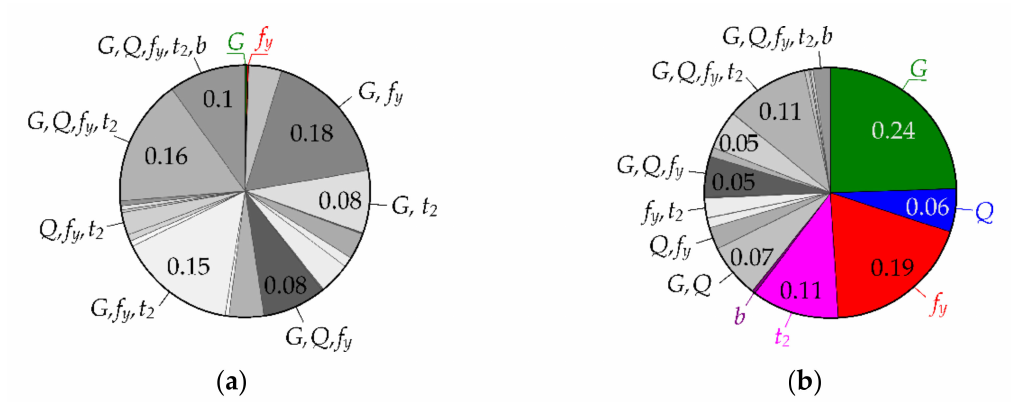
Figure 11. The results of SA for P f = 7.2 × 10 − 5 using: ( a ) P4 M ( P f ), Equation (27); ( b ) L M ( P f ), Equation